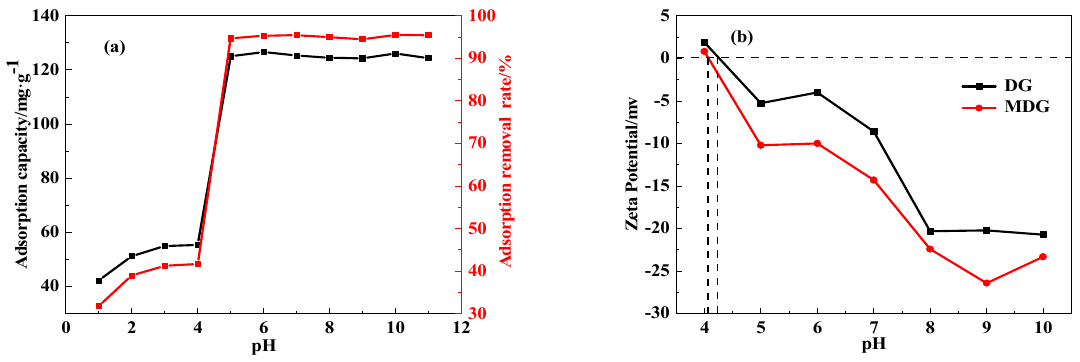
Figure 9. ( a ) Effect of pH on adsorption performance of MDG and ( b ) zeta potential analysis of DG and MDG.